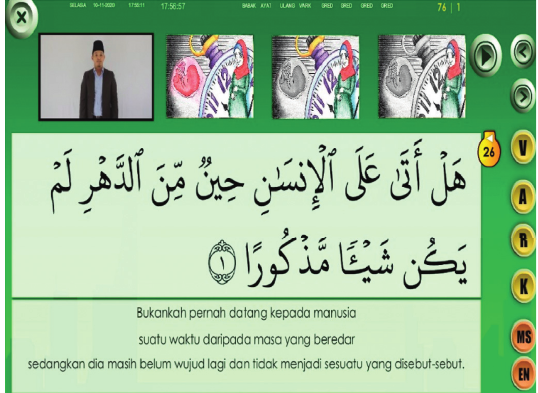
Figure 4: Memorization menu.